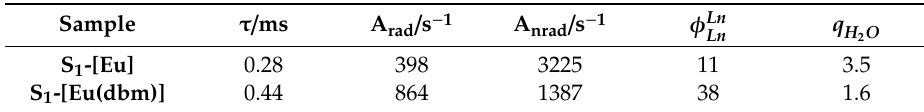
) for S 1 -[Eu] and 2 O